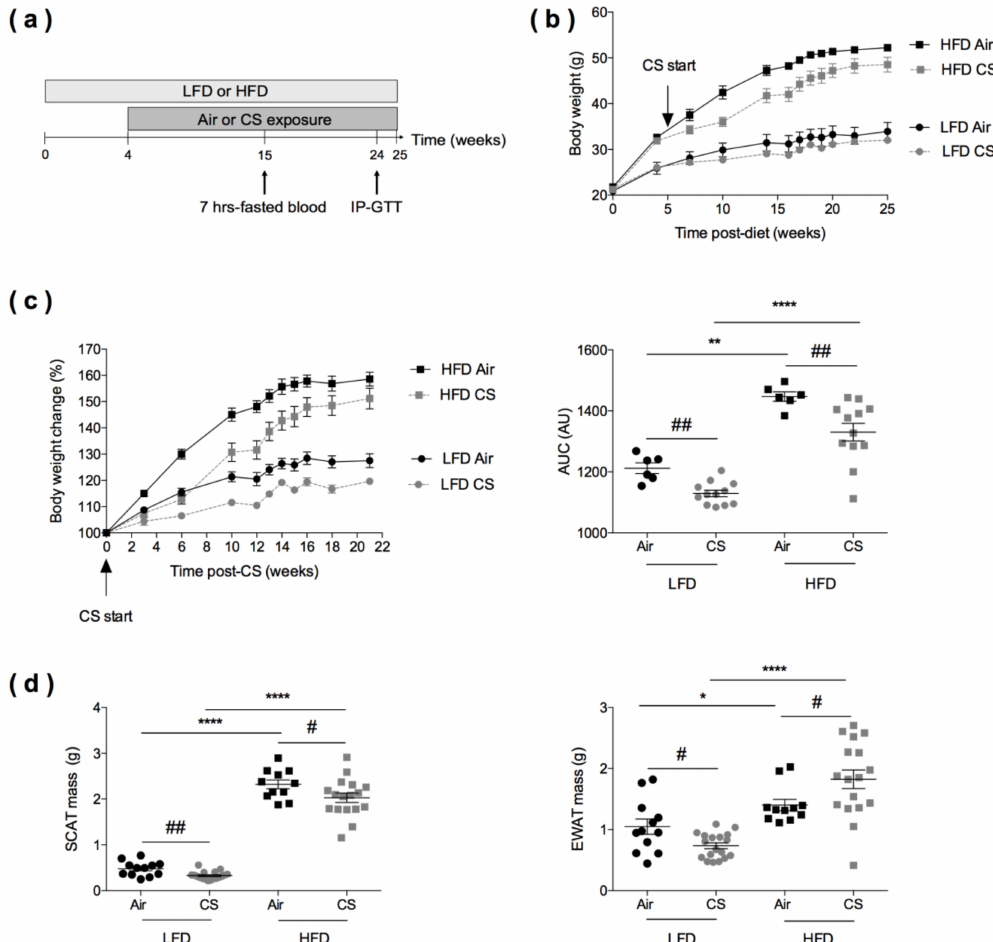
Figure 1. E ff ects of chronic cigarette smoke (CS) exposure on the body weight and fat mass of lean (LFD) and obese (HFD) mice. (a) Experimental design of the study: the day of the start of the study was defined as day 0 allowing the association of this time point with the schedule of CS in lean and obese mice. Mice were fed with low-fat diet (LFD, lean) or high-fat diet (HFD, obese) for four weeks and exposed to ambient air (Air) or to cigarette smoke (CS) (5 cigarettes / day, 5 days / week) for additional 21 weeks. Intraperitoneal glucose tolerance (IP-GTT) was performed at week 24. (b) Body weight evolution (expressed in g) of lean and obese mice exposed to Air ( n = 6) or CS ( n = 12) from week 0 to week 25. Data are expressed as mean ± SEM. (c) Body weight change from CS start to 21 weeks post-CS exposure (expressed as % body weight loss from body weight at CS start) (left panel), and corresponding area under the curve (AUC) values (expressed in arbitrary units (AU) (right panel). Data are expressed as mean ± SEM. (d) Masses (expressed in g) of subcutaneous (inguinal) white adipose tissue (SCAT) (left panel) and epididymal white adipose tissue (EWAT) (right panel) were recorded at sacrifice, n = 11–12 in Air groups and n = 17–18 in CS groups. Data are expressed as individual and mean ± SEM values. * p < 0.05, ** p < 0.01, **** p < 0.0001, * correspond to diet e ff ect (HFD vs. LFD), and # p < 0.05, ## p < 0.01, #correspond to CS e ff ect (CS vs.